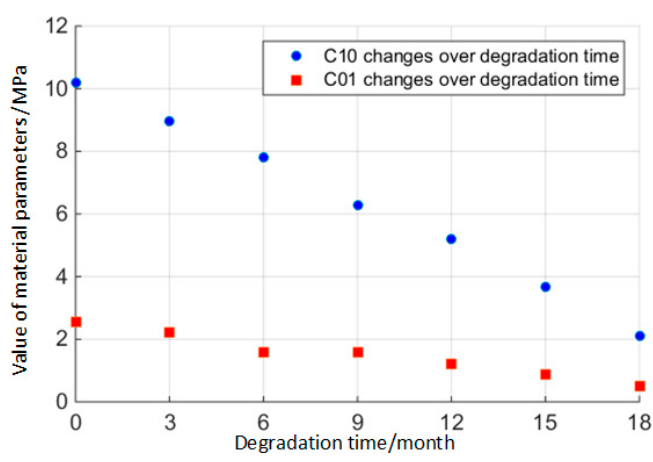
Figure 9. Degradation of rubber material parameters over time.